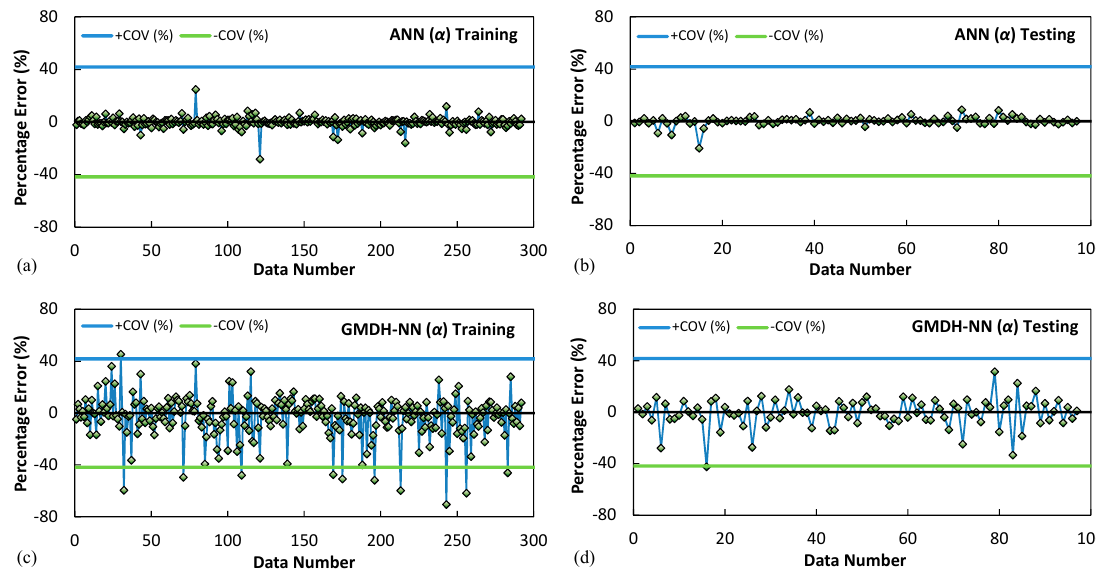
Figure 20. Error values in test and train stages of α in proposed models: ( a , b ) ANN ( α ); ( c , d ) GMDH-NN ( α ).